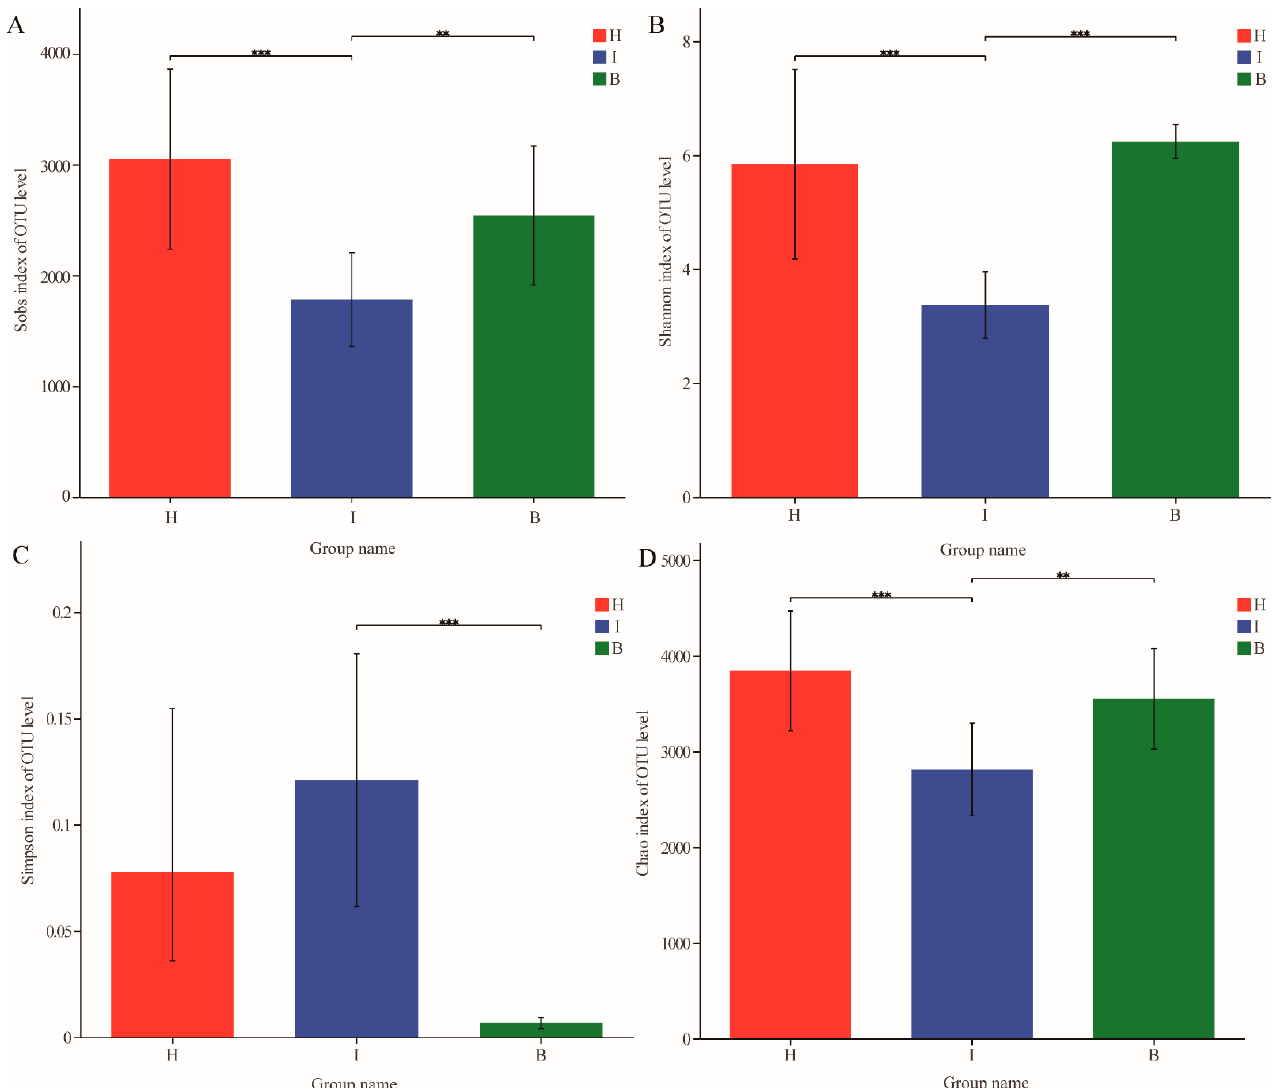
Figure 1. Comparison of alpha diversity indices of the bacterial communities at different sites. ( A ) Comparison of the Sobs index of the bacterial communities at different sites, ( B ) comparison of the Shannon index of the bacterial communities at different sites, ( C ) comparison of the Simpson index of the bacterial communities at different sites, and ( D ) comparison of the Chao index of the bacterial communities at different sites. Higher Sobs and Chao values indicate a higher richness; higher Shannon and lower Simpson values indicate a higher diversity. Statistical significances between the two sites were considered at ** p < 0.01, and *** p < 0.001 by Welch t -test. B: hemolymph (B1–B12); H: hepatopancreas (H1–H12); I: intestine